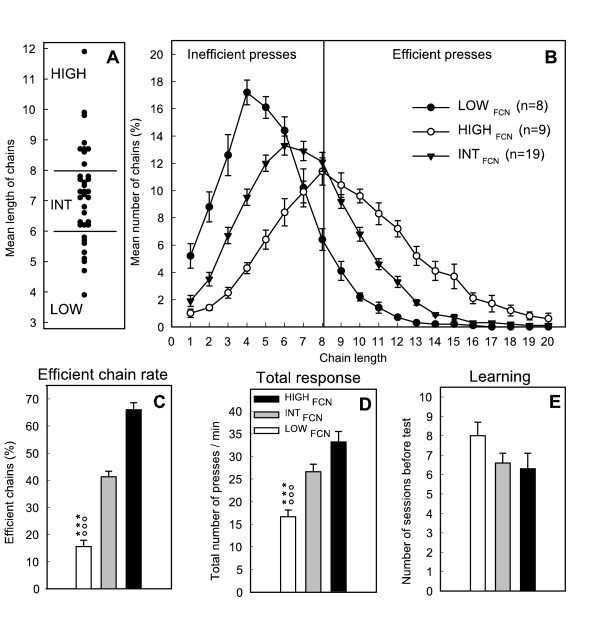
Inter-individual differences in impulsivity of rats measured in the FCN8 task. A: distribution of individual scores of rats (mean chain length over the last 7 days) and selection of rats with high level of inhibition (HIGHFCN, scores > 8) low level of inhibition (LOWFCN, scores < 6) and intermediate levels (INTFCN); B: distribution (%) of mean chain lengths of efficient (≥ 8) or inefficient chains (< 8) of the three groups. Optimal performance (8) is indicated by the vertical line. C: percentage mean of efficient chains; D: total number of presses per min and E: number of sessions needed to reach the test phase of the three groups. ANOVA (NK): ***, p < .001 for comparisons between LOW and HIGH groups; °°°, p < .001 for comparisons between LOW and INT groups.